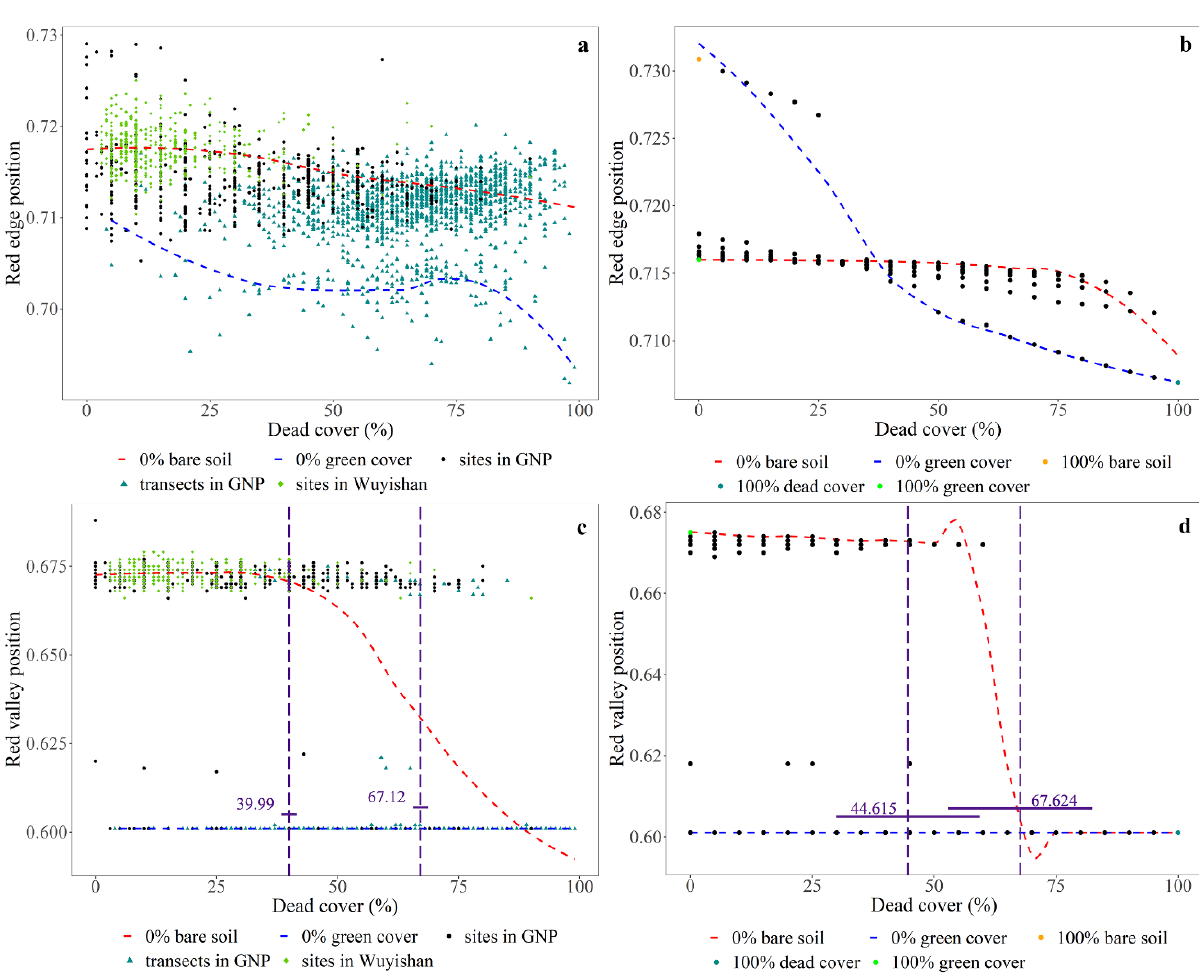
Figure 4. The relationship between red-edge position, red valley position and dead cover (“sites in GNP”, “transects in GNP” and “sites in Wuyishan” refer to the quadrat data collected in the sample sites in Grassland national park (GNP), in the transects in GNP, and in the sample sites in Wuyishan National Park (WNP), respectively; the red dash line refer to the linear relationship in the situation when the coverage of bare soil equals to 0%; the blue dash line means the relationship in the situation when green cover equals to 0%). The relationship between red-edge position ( a ), red valley position ( c ) from field measured hyper-spectra and dead cover; the relationship between red-edge position ( b ), red valley position ( d ) from simulated hyper-spectra and dead